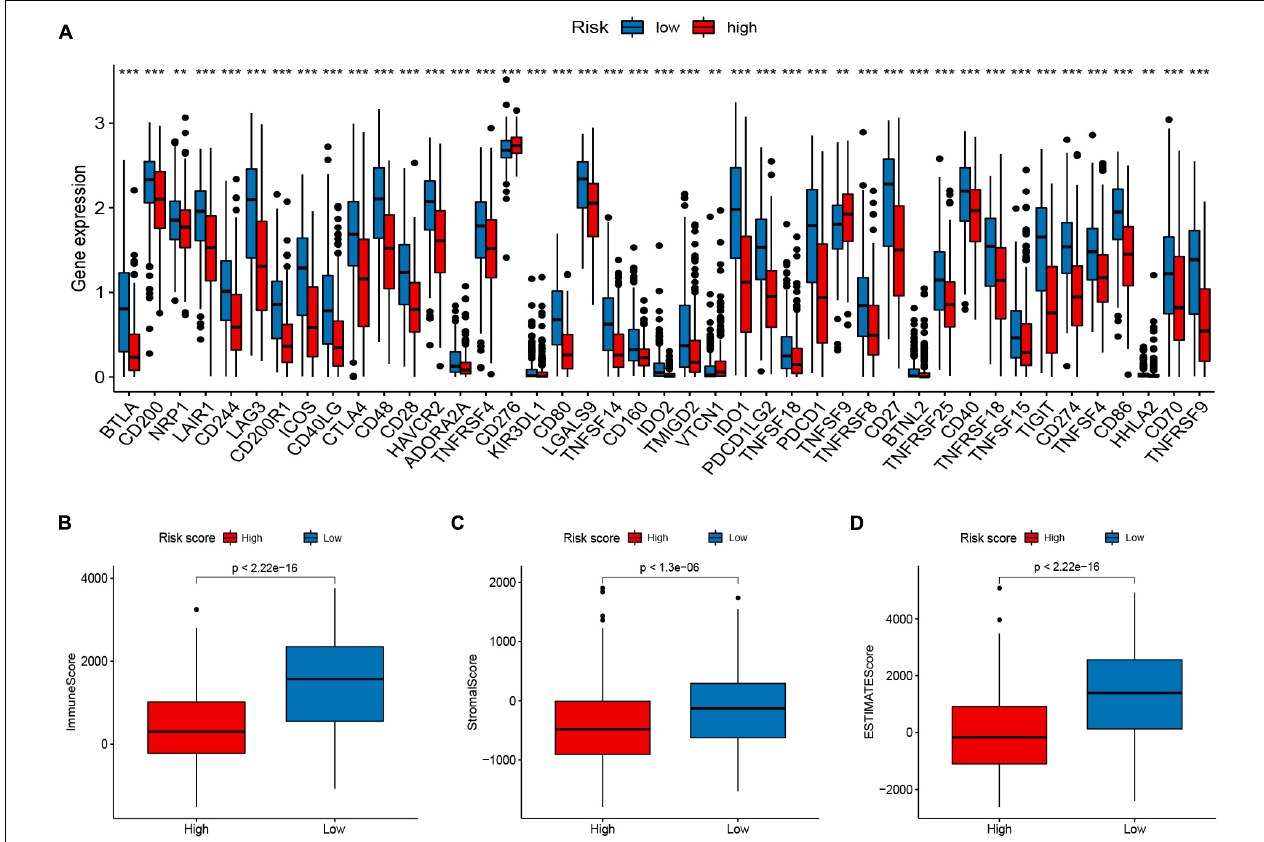
FIGURE 5 | Relationships between the signature and immune checkpoints as well as TME score. (A) Immune checkpoints. (B–D) The TME score (Immune score, Stromal score, and Estimate score).